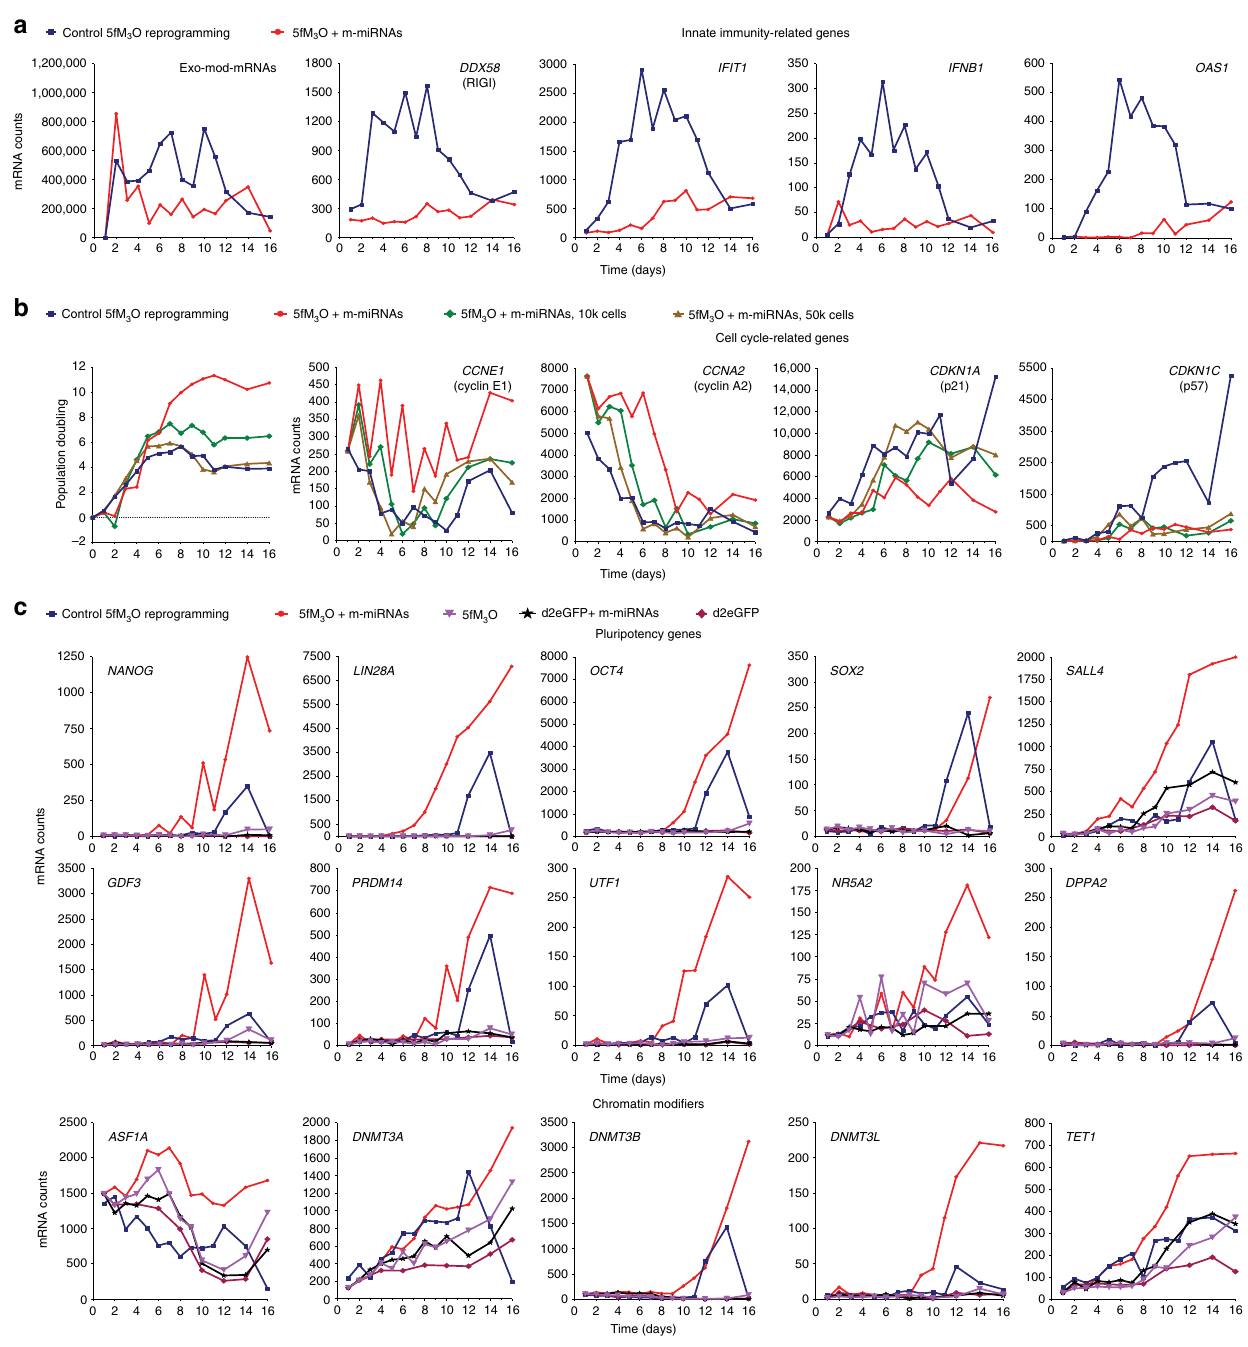
with Geltrex ® Matrix (Thermo Fisher Scienti fi c) at 100× dilution according to the manufacturer ’ s instruction. Y-27632 (Sigma-Aldrich) was used with each passaging at a fi nal concentration of 10 μ M to improve the survival of pluripotent stem cells. The medium was replaced daily. Y-27632 was removed the next day after each new passage, and iPSCs were cultured without Y-27632 until the next passage. All cell lines used in the study were tested negative for mycoplasma using Universal Mycoplasma Detection Kit (ATCC). The cumulative PD level in Fig. 7b and Supplementary Fig. 16b was calculated by using the formula: PD = log( n f / n i )/log2, where n i is the initial number of cells and n f is the fi nal number of cells at each time point described in Supplementary Fig. 14. RNA transfection . Transfections with mod-mRNAs (encoding mWasabi, d2eGFP, and reprogramming factors), m-miRNAs, and control siRNAs were performed using Lipofectamin ® RNAiMAX TM (RNAiMAX) (Thermo Fisher Scienti fi c). RNA